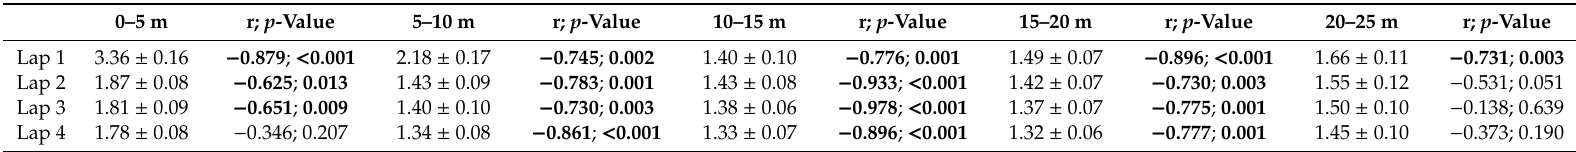
Table 8. Mean swimming velocity (m / s) ± standard deviation for each 5 m segment during the 100 m breaststroke and correlation coe ffi cients with the finishing time.